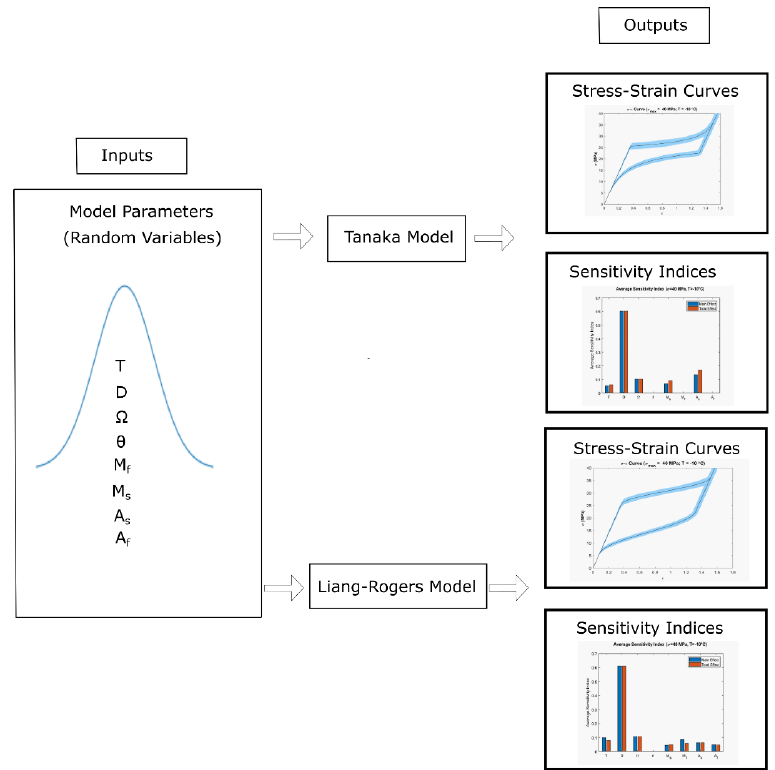
Figure 1. Uncertainty in the stress-strain curves and sensitivity indices as outputs for Tanaka and Liang-Rogers models using eight model input parameters.